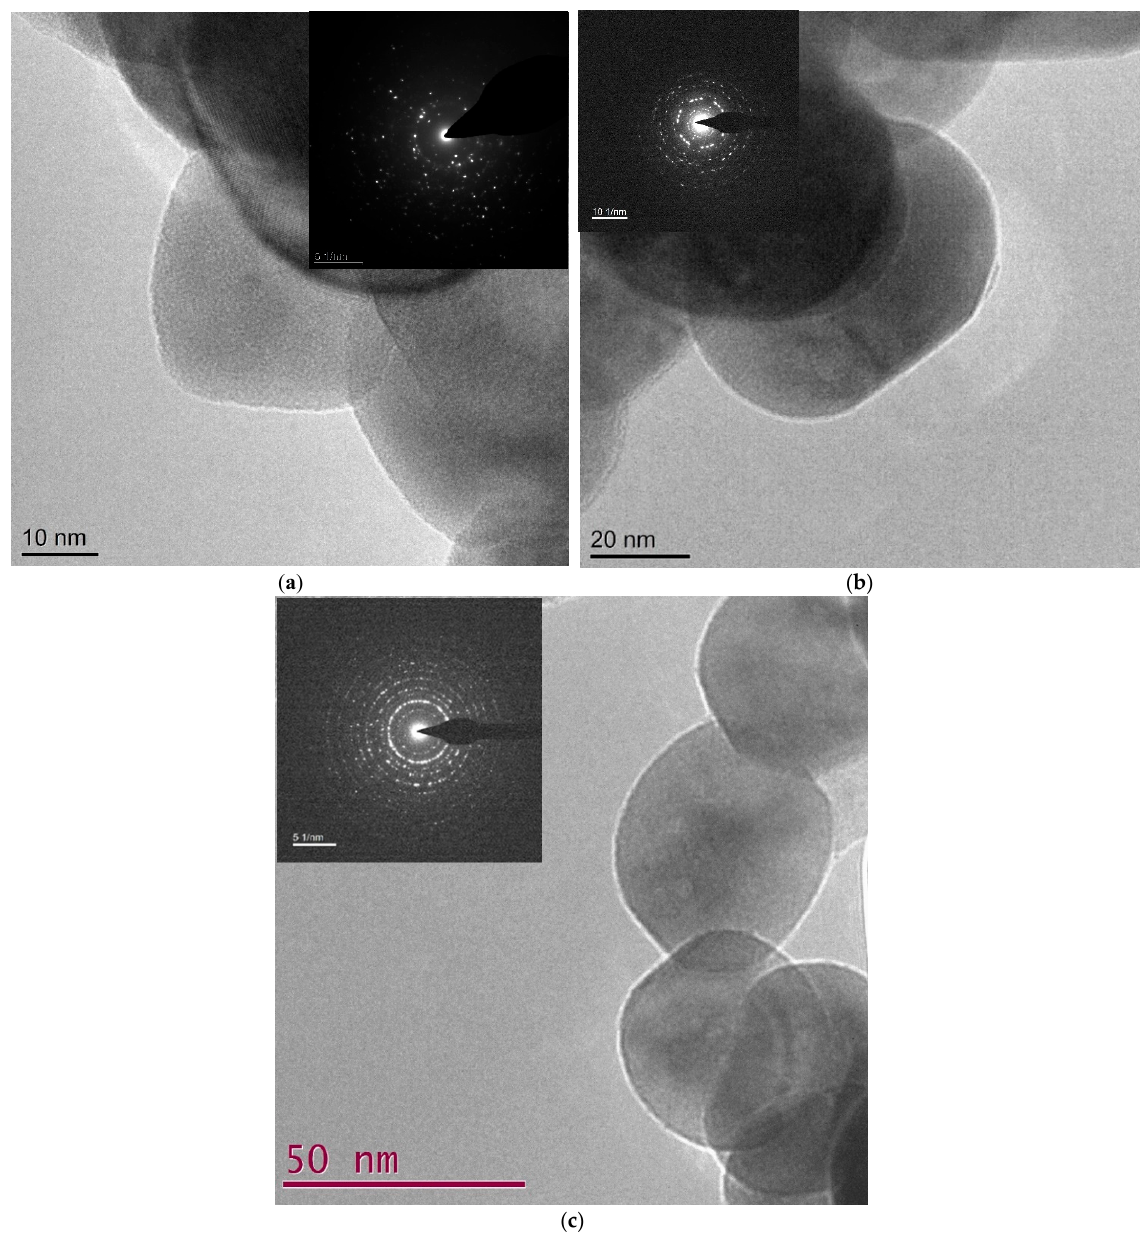
Figure 4. TEM images and selected electron area diffraction (SAED) patterns of calcined LSCF 6428 ( a ), 6455 ( b ), and 6482 ( c ) at 700 °C for 2 h.